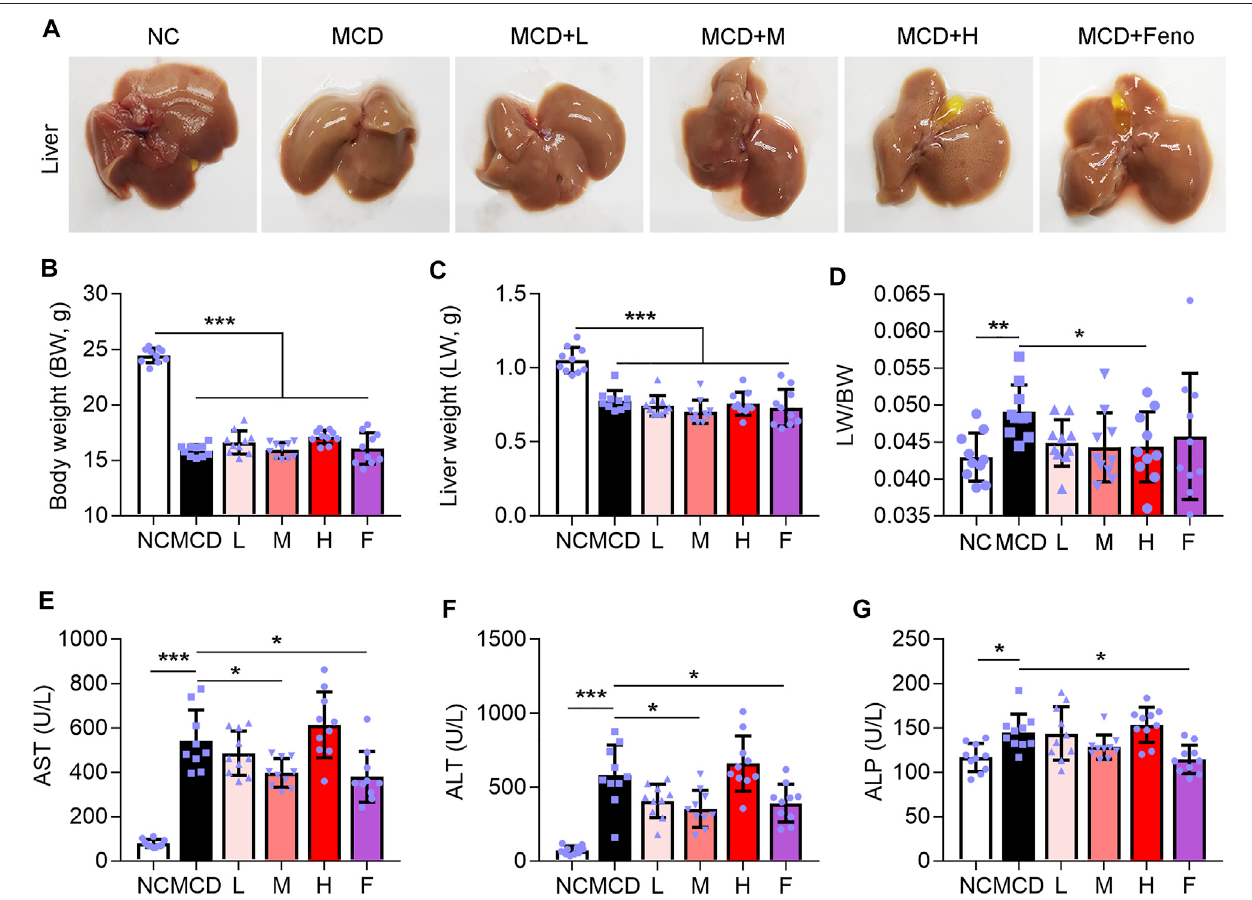
FIGURE 3 | Ganweikang tablet alleviates liver lesions in MCD-induced NASH mice. Eight-week-old male mice on a C57BL/6J background were fed an MCD diet for a total of 8 weeks, with the Ganweikang tablet intervention at the fourth week, and the serum and liver were collected at the time of mouse euthanization. (A) Representativeimagesofmouseliver. (B – D) Thebodyweight(BW),liverweight(LW),andtheratioofLWtoBW, n =10pergroup. (E – G) SerumAST,ALT,andALPwere detected by kit, n = 10 per group. * p < 0.05, ** p < 0.01, *** p < 0.001, by one-way ANOVA with Bonferroni